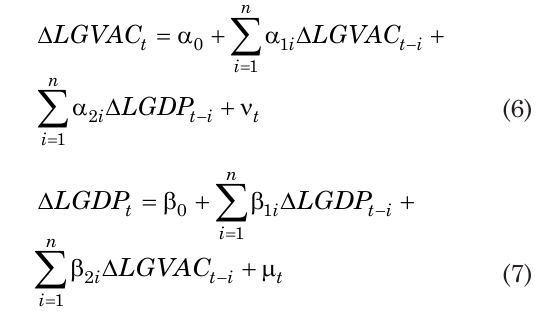
table 3. Granger causality tests